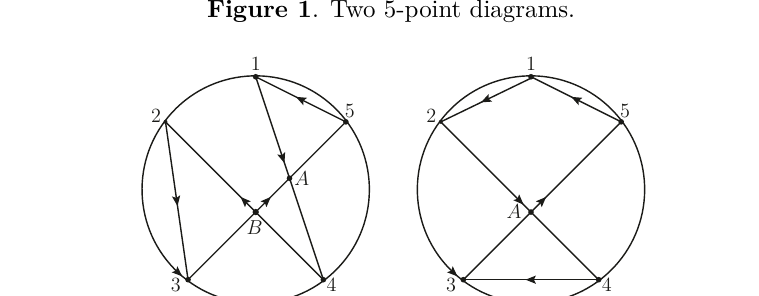
Figure 1 . Two 5 -point diagrams.